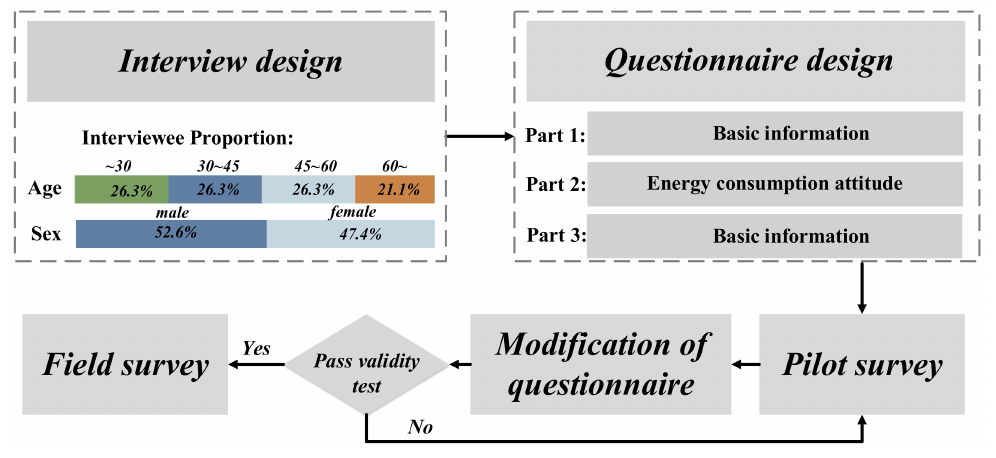
Figure 1. The procedures of study design.